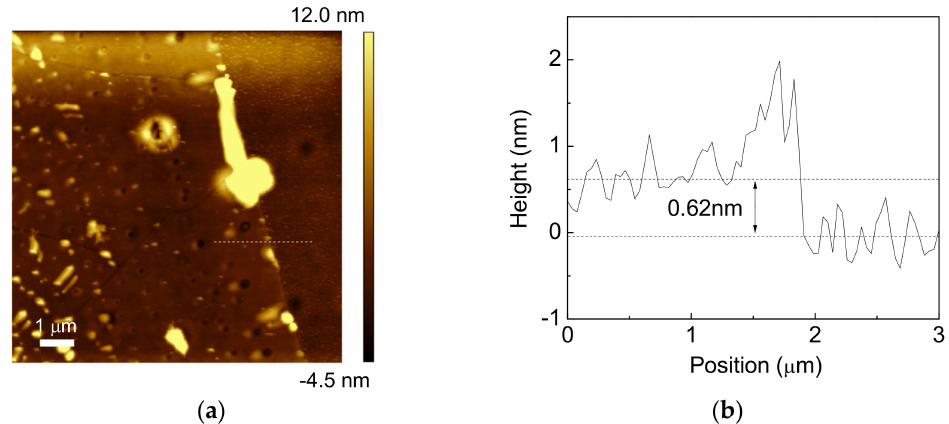
Figure 4. AFM image and cross section of MoS 2 grown on a SiO 2 /Si substrate. The line indicates the location where the cross section was determined. Scale bar in the AFM image represents 1 µ m. ( a ) AFM; ( b ) Cross section of the marked area in